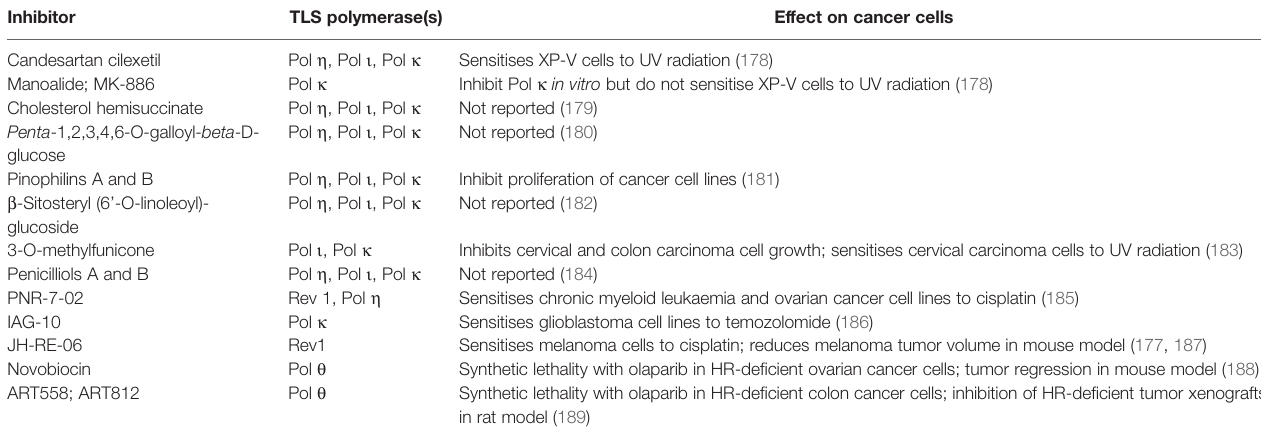
TABLE 3 | Inhibitors of TLS